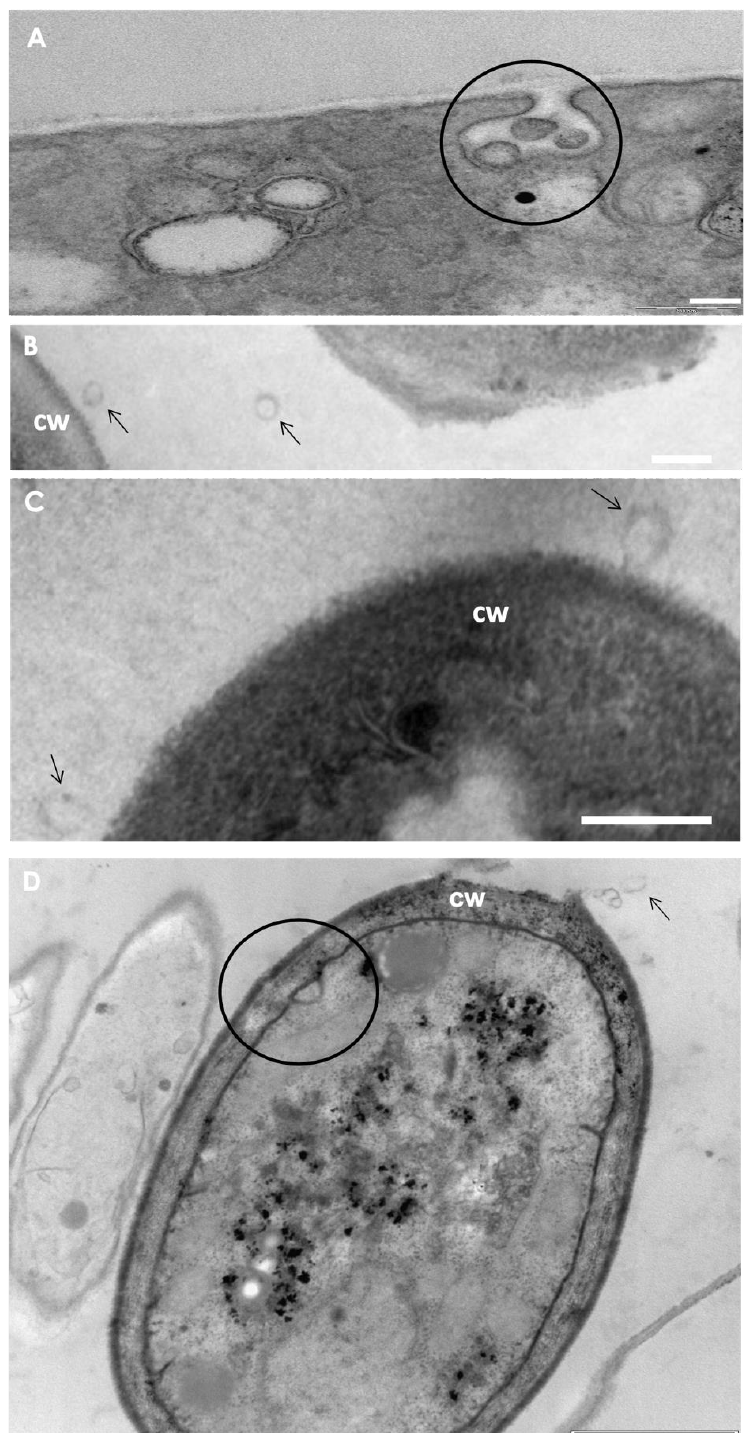
Figure 7. Transmission electron microscopy (TEM) showing vesicle-like structures in Scedosporium spp. ( A ) TEM images demonstrated the presence of vesicles within a membrane invagination in S. minutisporum hyphae. The black circle evidences the invagination. Bar: 1 µm. ( B , C ) TEM micro- graphs showing vesicle bodies in the extracellular milieu of S. apiospermum hyphae. Arrows evi- dence the vesicular bodies. cw, cell wall. Bar: 250 nm. ( D ) TEM image of S. apiospermum conidia. The black circle evidences the membrane invagination, and the arrow evidences the vesicular bodies. Cw, cell wall. Bar: 1 µm.